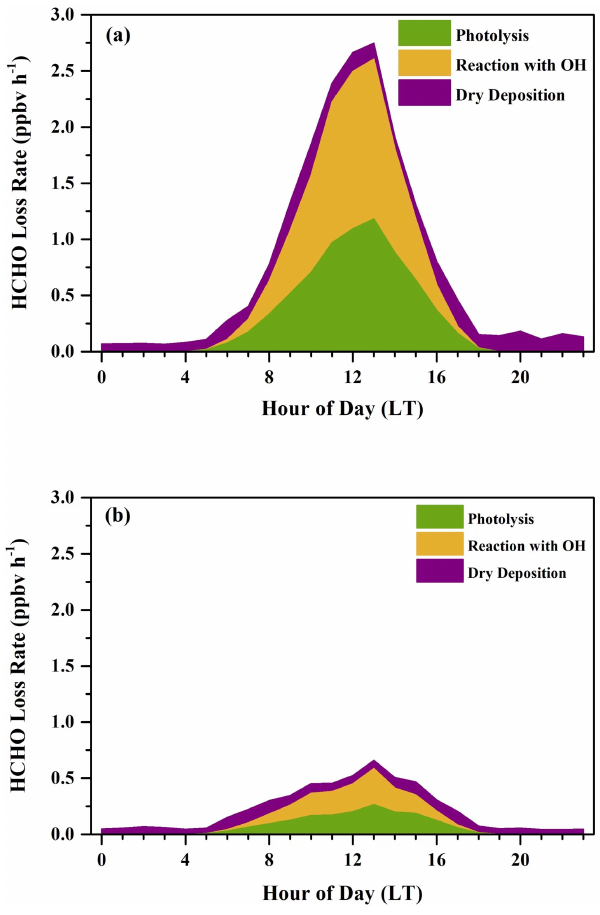
Figure 9. Average diurnal variations in HCHO loss rates (ppbvh − 1 ) determined from photolysis, reaction with OH radicals, and dry deposition during (a) the sunny period and (b) the cloudy and rainy